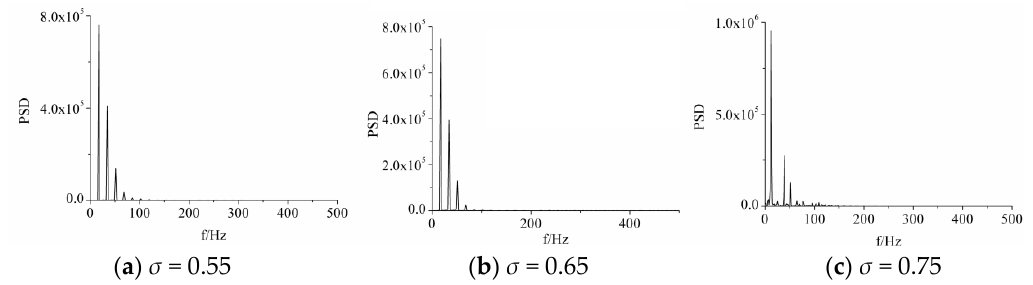
Figure 20. Acoustic power spectral density for σ = 0.55, 0.65, and 0.75.